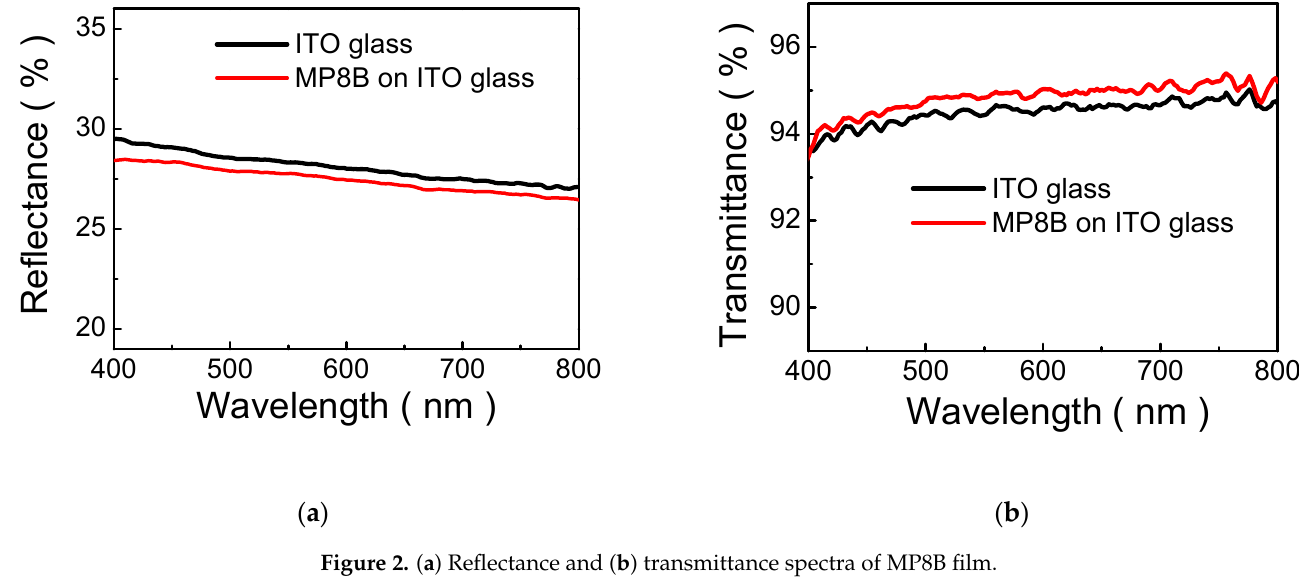
Figure 2. ( a ) Reflectance and ( b ) transmittance spectra of MP8B film.